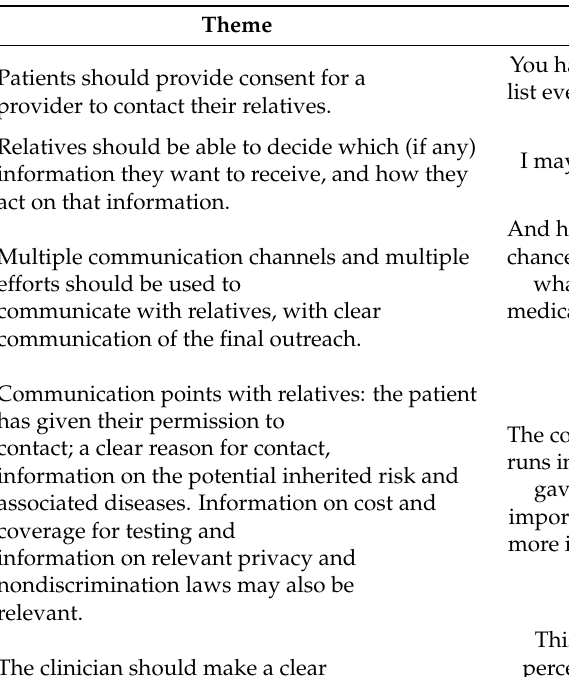
Table 3. Design requirements for health system-led direct contact